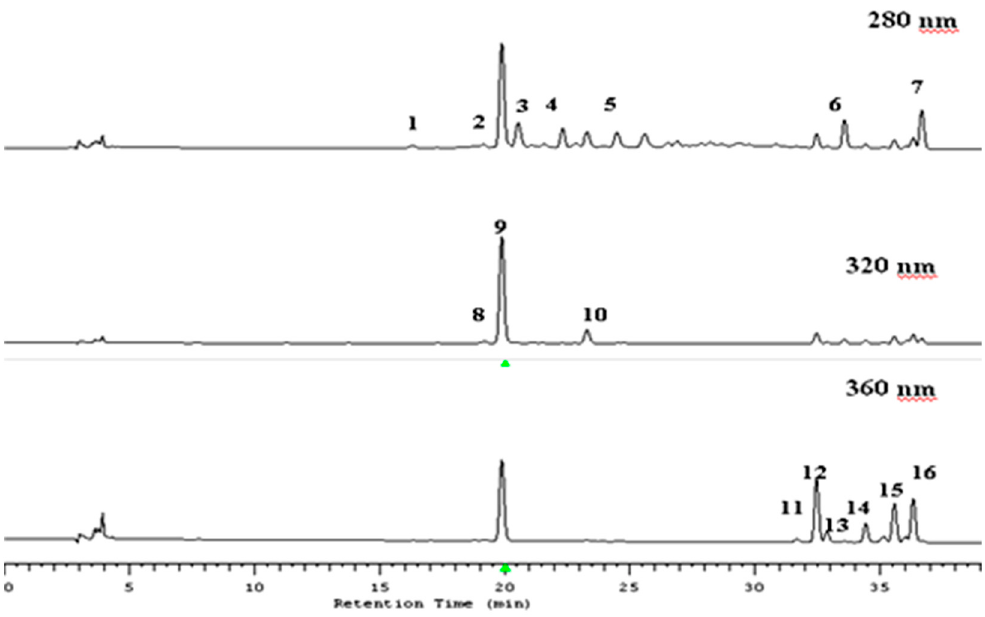
Figure 1. HPLC chromatograms of the apple extract at 280, 320 and 360 nm. 1 — procyanidins B1; 2 — (+)-